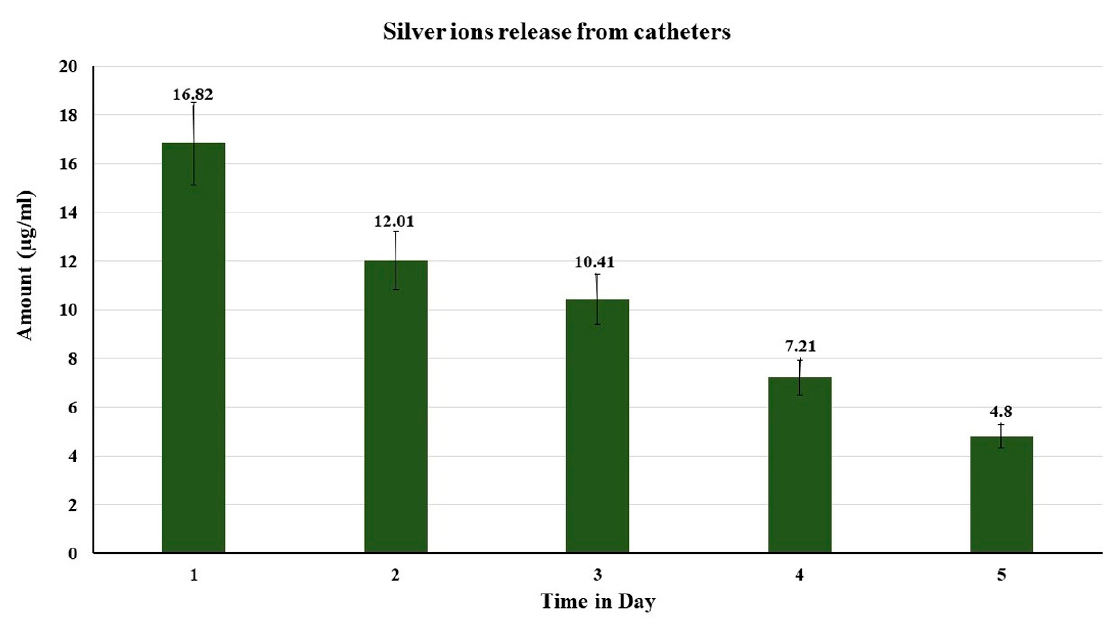
Figure 5. The amounts of silver ion released from catheters coated with silver nanoparticles and varnished with mastic from day 1 to 5.